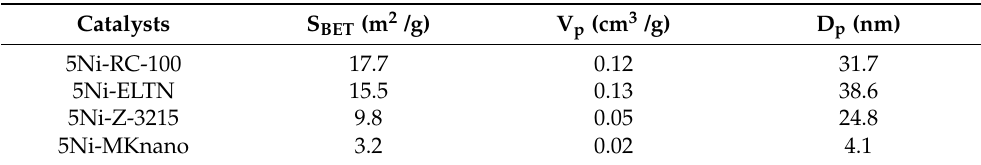
Table 1. Textural properties of Ni catalysts supported on various ZrO 2 sources: BET specific surface area (S BET ), pore volume (P V ), and pore width (D P ). Catalysts